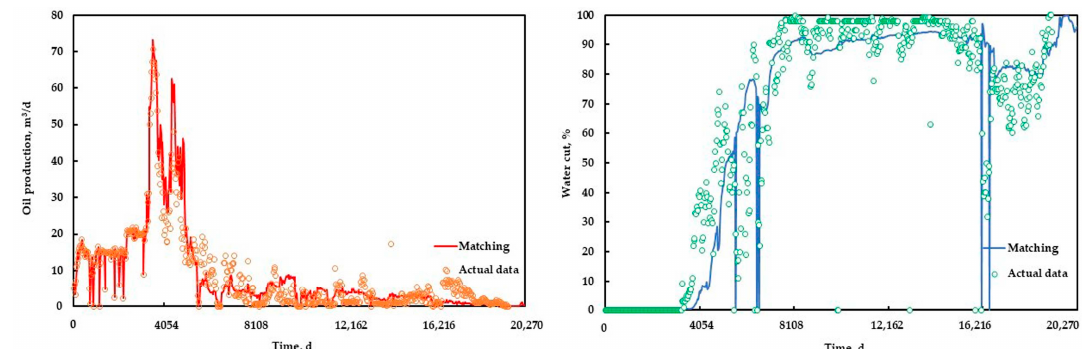
Figure 13. The history matching results of the reservoir.